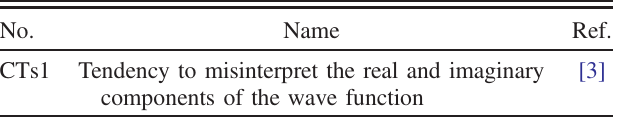
TABLE VIII. Difficulty that exhibits both content and tran- sition errors in a problem that requires frame shifting. This difficulty is labeled “ CT ” for content and transition errors and s because its problem requires shifting.